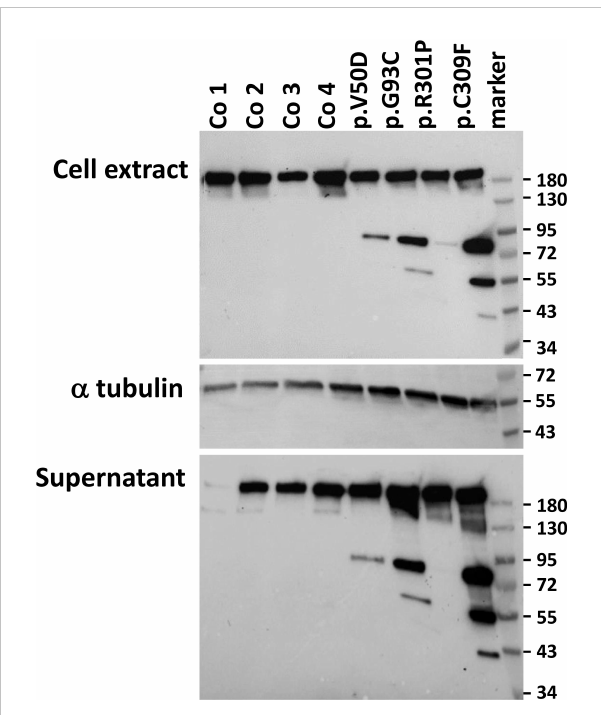
FIGURE 1 Western blot analysis of collagen I expression in control (Co) and pEDS fi broblasts. Cell extracts and cell supernatants were probed with an anti-collagen I antibody. The signal at approx. 150 kDa represents procollagen, which was present in all fi broblasts; absence of this signal in the supernatant of control 1 may be due to rapid removal of the C-terminal antigen region for the collagen I antibody. Additional collagen I bands at approximately 72 kDa, 55 kDa and 43 kDa in pEDS fi broblasts and supernatants indicate cleavage of a proportion of collagen I. Differences in collagen I fragmentation may be attributed to the fact that the cells come from different donors and carry different C1R variants, as indicated. Expression of alpha tubulin was analysed as loading control. This fi gure is representative of three independent experiments with similar